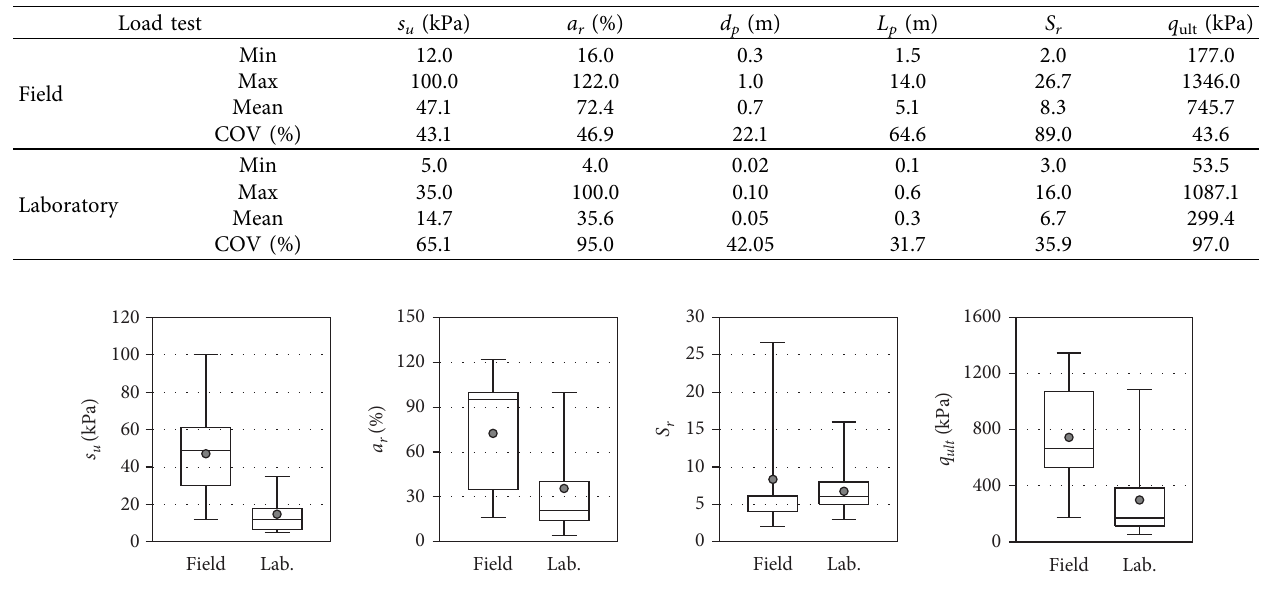
Figure 5: Comparison of box plot for feld and laboratory test